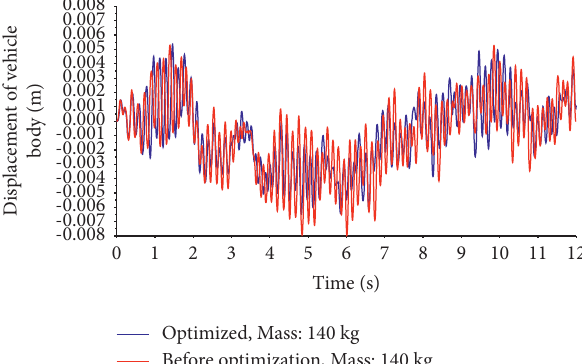
Figure 21: Comparison of the optimization results of the time-domain vehicle body displacement at a 140kg